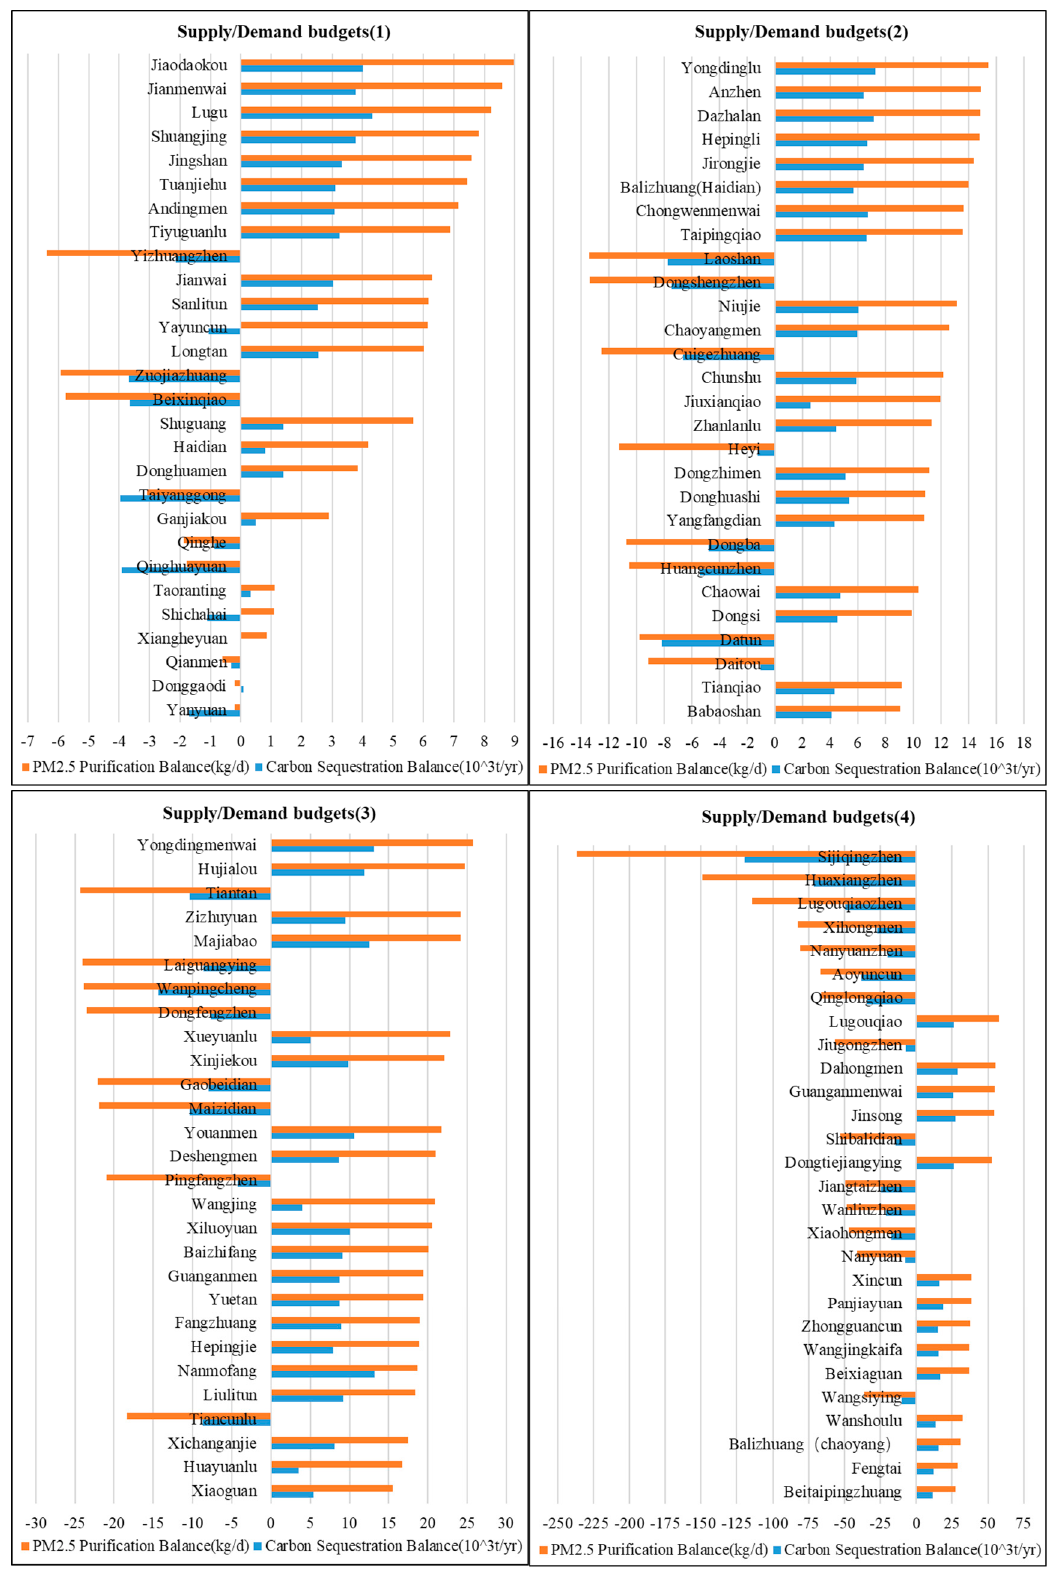
Figure 8. Budgets of the ecosystem service (ES) supply and demand within the 5th Ring Road of Beijing at the administrative unit scale.